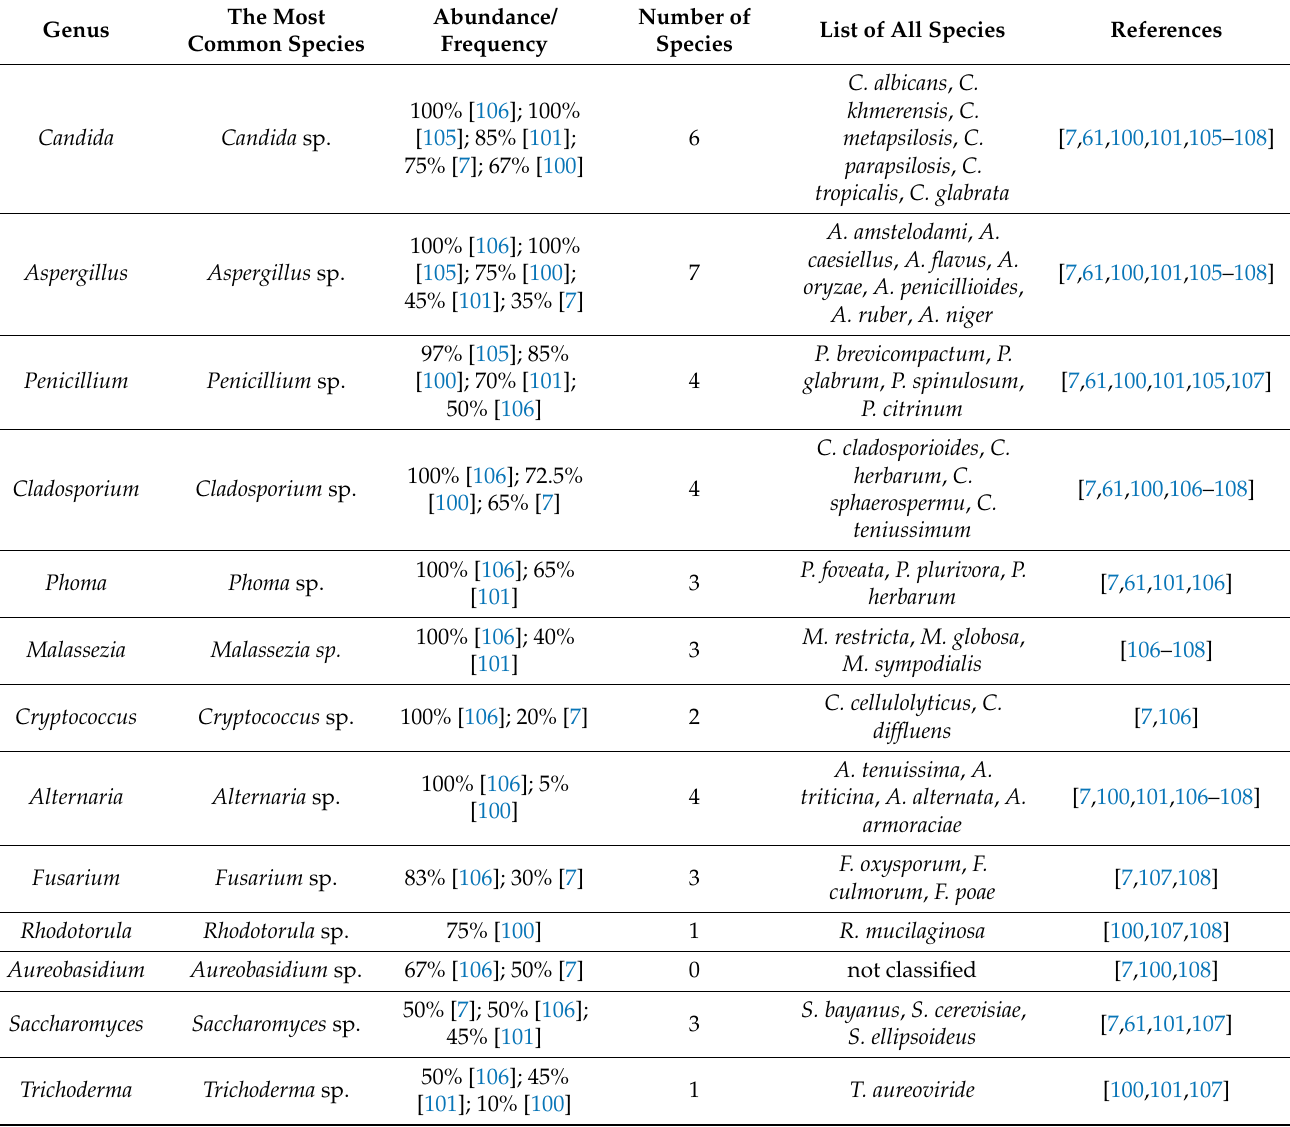
Table 5. The list of chosen oral mycobiome colonizers. The table summarizes the relative abundance (or frequency) of representative taxa, number and summary of all species described in the